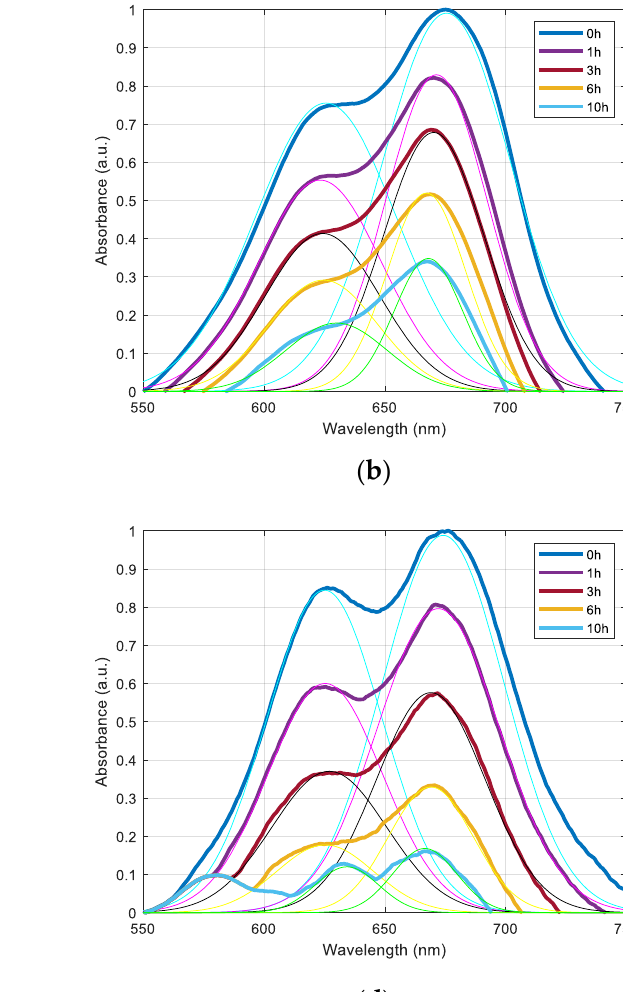
Figure 9. Photodegradation rates after total irradiation of the different samples for 10 h. ( a ) PAA + β -CD; ( b ) PAA + β -CD//TiO 2 /PAA; ( c ) PAA + β -CD//TiO 2 /PAA + WO 3 ; ( d ) PAA + β -CD//TiO 2 /PAA + Fe 2 O 3 .